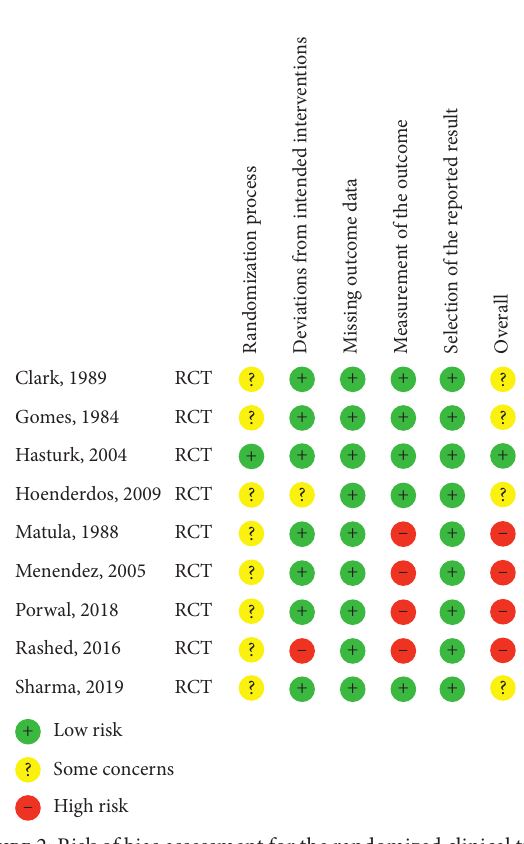
Figure 1: Flowchart of the studies during the